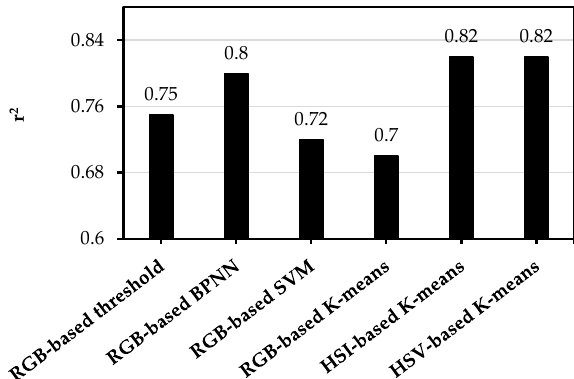
Figure 6. The relationships between measured flower number and classified flower coverage area (FCA) by different classification methods. BPNN and SVM represent back propagation neural network and support vector machine, respectively.